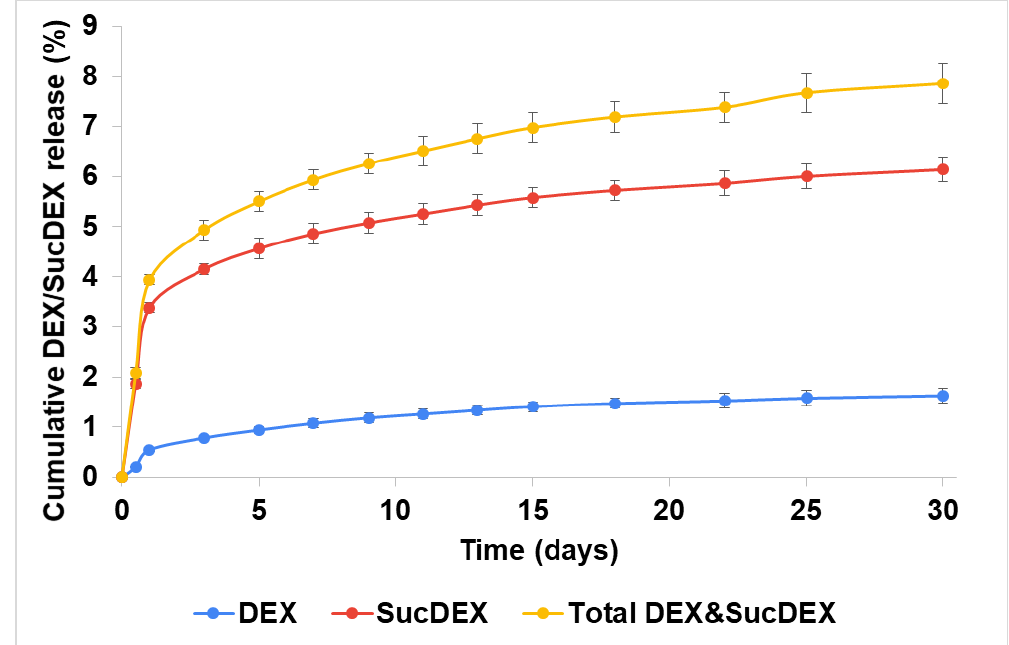
Figure 4. Release of DEX and SucDEX from the SucCS-DEX-5 particles; n = 3, error bars represent one standard devia- tion.